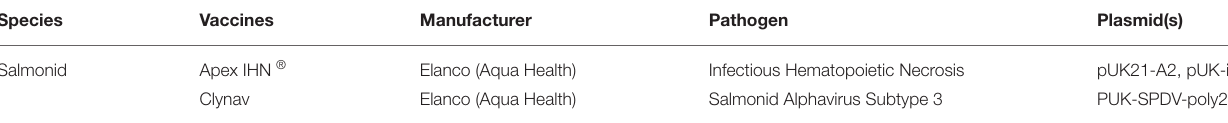
TABLE 2 | DNA vaccines.